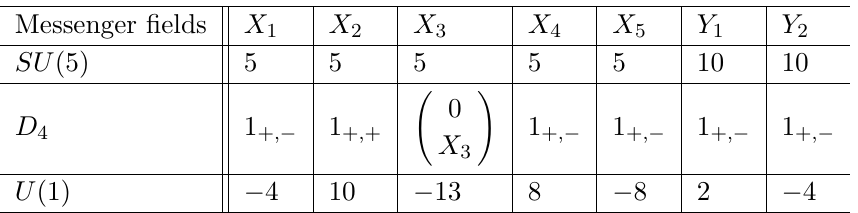
Table 8 . Messenger fields relevant in our model and their D 4 representations as well as their U(1) charges. The messenger fields X live in 5 -dimensional representation while Y i representation. We assume that their mass is around the GUT scale.